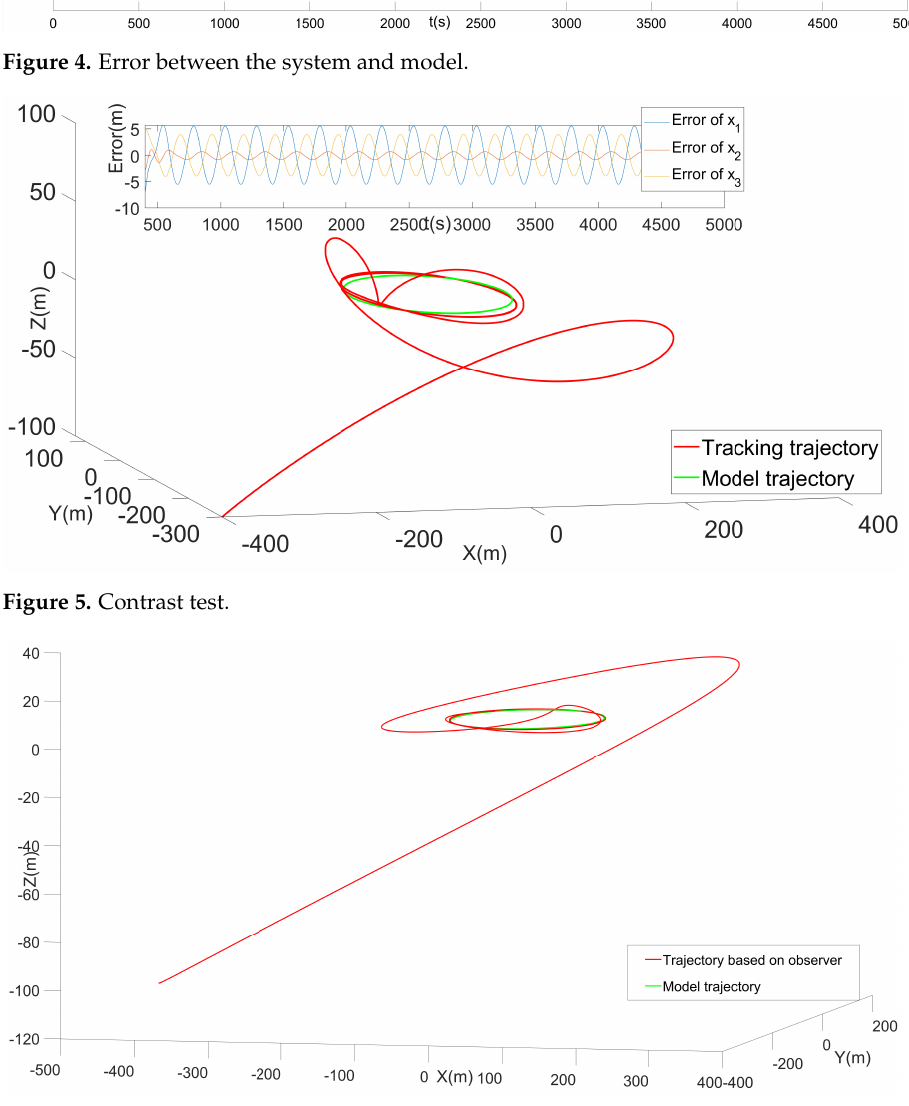
Figure 6. Trajectory based on the